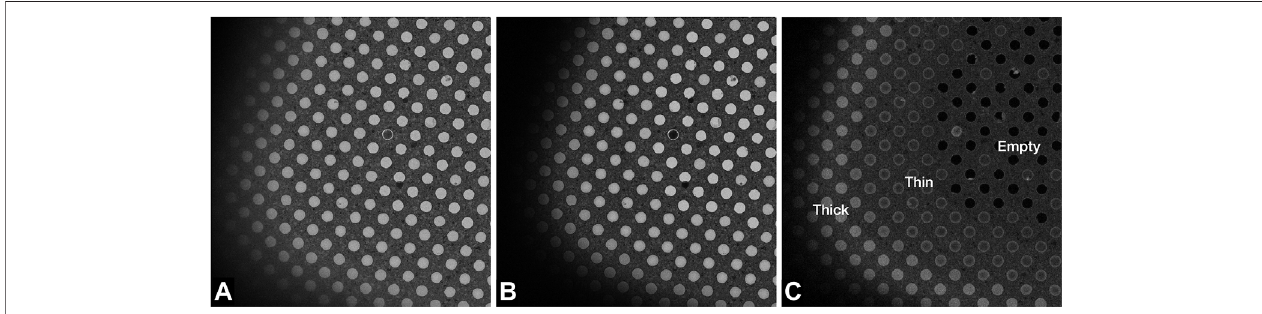
FIGURE 4 | Images of a Quantifoil UltrAuFoil 1.2/1.3 grid, acquired on a Thermo Scienti fi c Titan Krios G1with Gatan Bioquantum K2 detector using EFTEM SA mode 2250x magni fi cation ( fi eld of view ×23 24 μ m) with a 70 μ m objective aperture inserted, 1-s exposure, total dose 0.003 e/Å 2 . Image contrast/brightness has